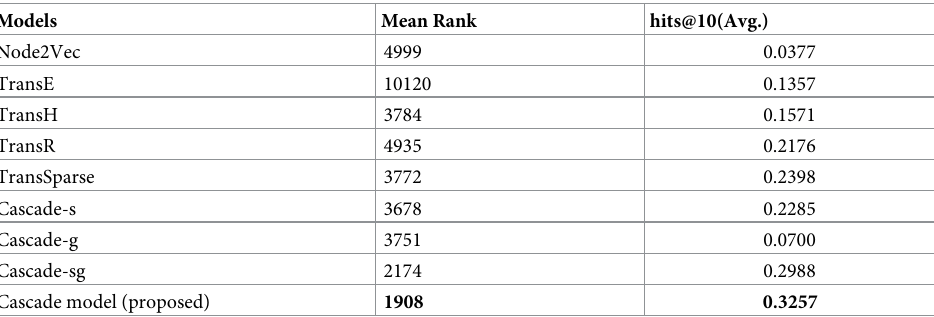
Table 5. Entity prediction